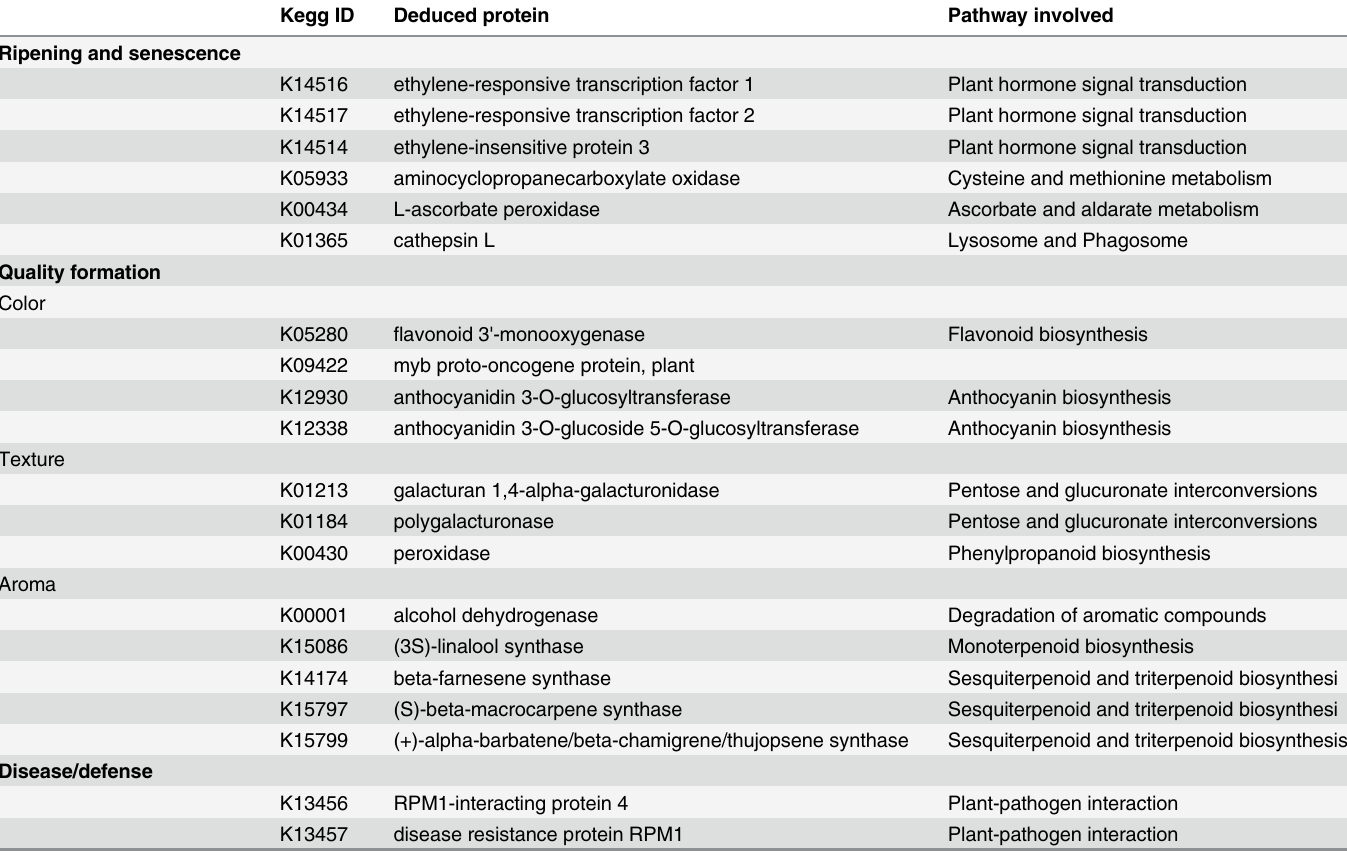
Table 4. Annotated contigs associated with fruit ripening and senescence, fruit quality formation and disease/defense metabolism in Morella rubra